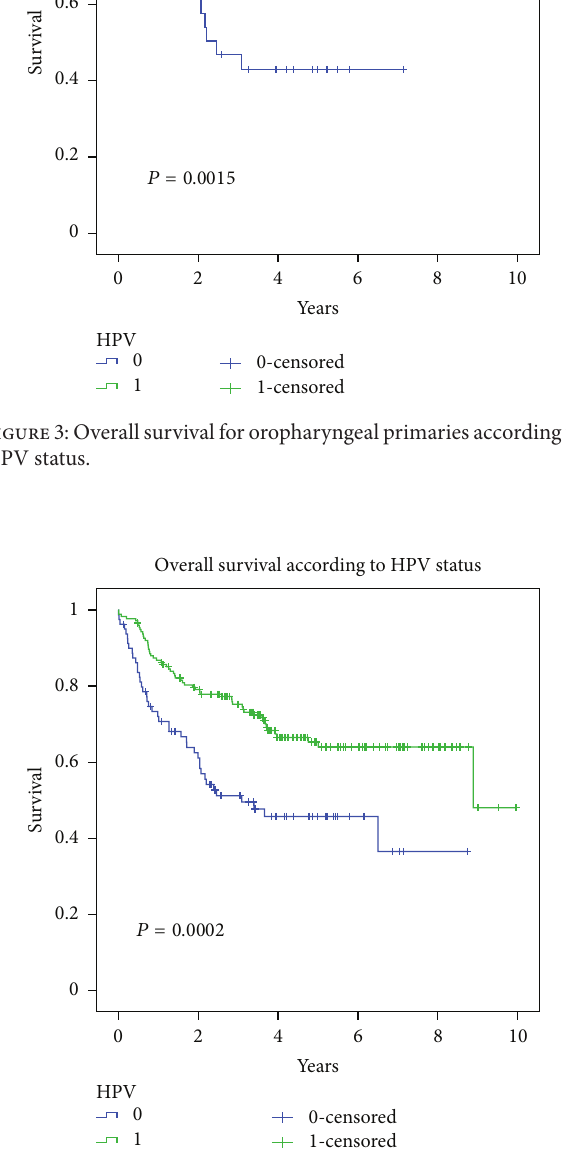
Figure 4: Overall survival according to HPV